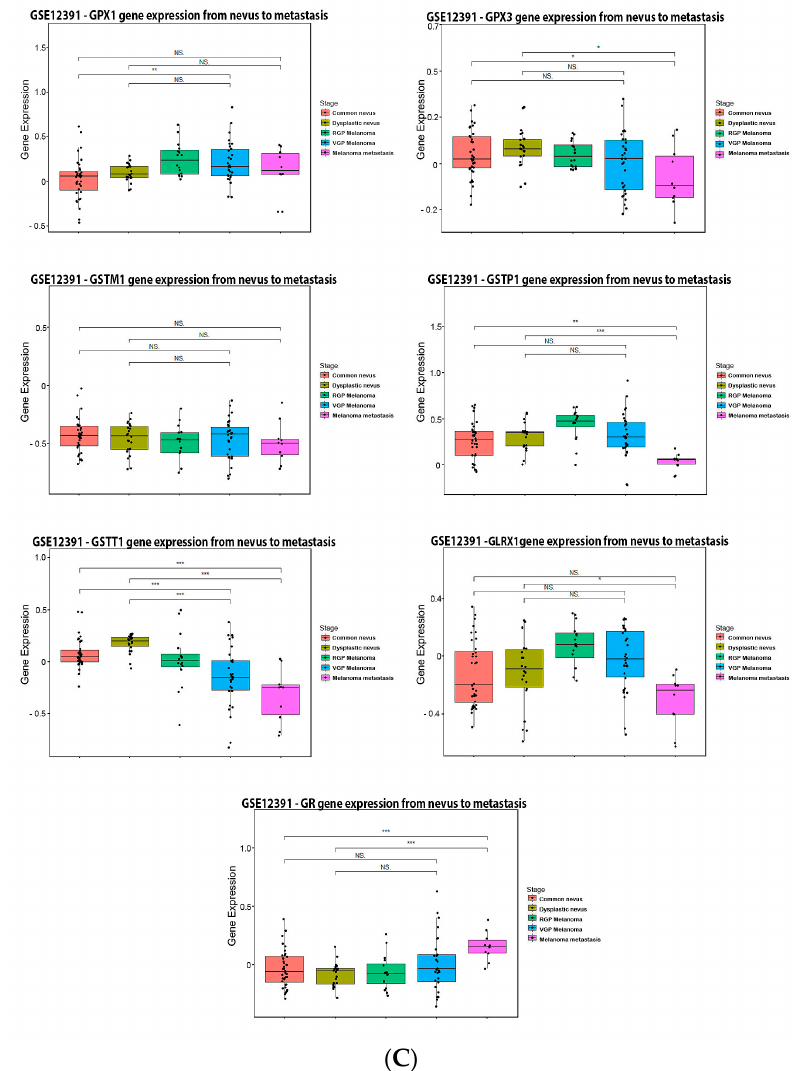
Figure 5. Glutathione-related enzymes on melanoma. ( A ) Percentage of patients with altered genes and types of genetic alterations; ( B ) overall patient survival status, and ( C ) expression in melanoma progression. Red boxes represent the common nevus, yellow boxes the dysplastic nevus, green boxes the radial growth phase (RGP) melanoma, blue boxes the vertical growth phase (VGP) melanoma, and purple boxes the metastatic melanoma. The statistical analysis was performed by ANOVA followed by Tukey test, *** p < 0.001, ** p < 0.01, * p < 0.05, when compared to common or dysplastic nevus. NS: Not